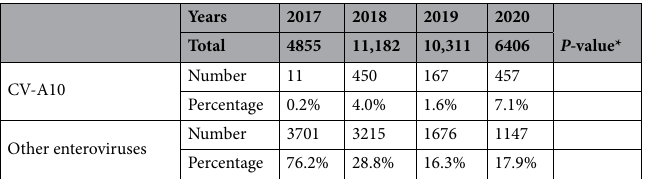
Table 2. The epidemiological description of HFMD in Kunming, 2017–2020. *Comparison of HFMD patients with age group, gender and hosting classification in 2017–2020 by chi-square test. **Significant statistical